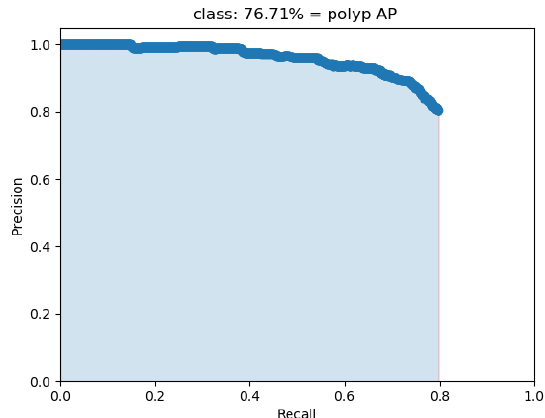
Figure 9. The PR curve for the binary polyp identification system.